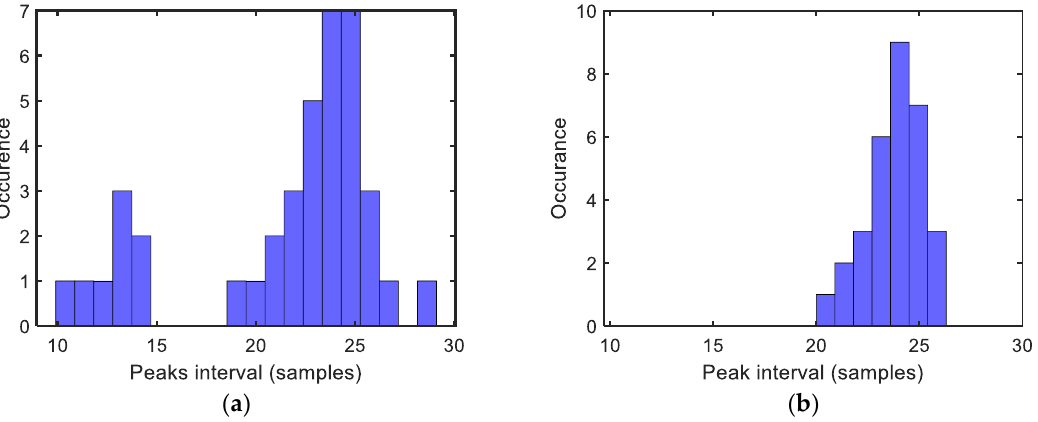
Figure 9. Histogram of heart rate interval values ( a ) before and ( b ) after applying the proposed algorithm for the removal of noisy peaks from the received vital signal.